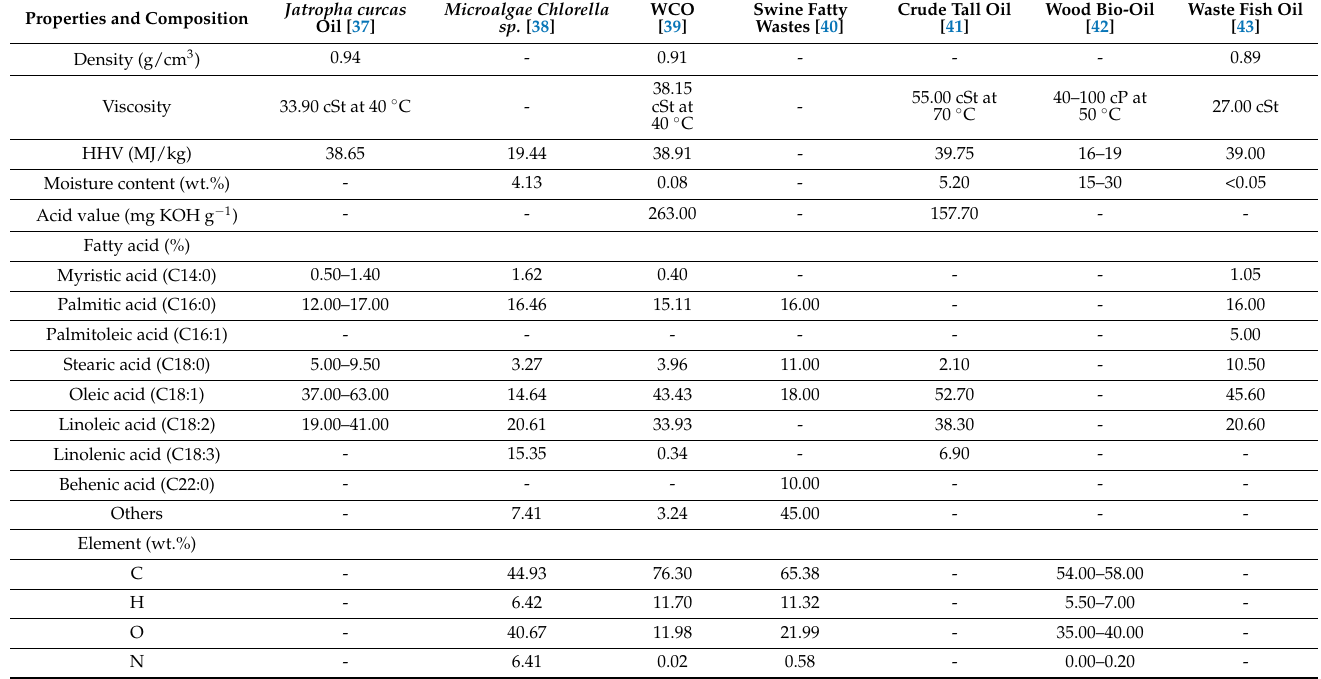
Table 1. Properties and compositions of various non-edible oils and lipid-rich